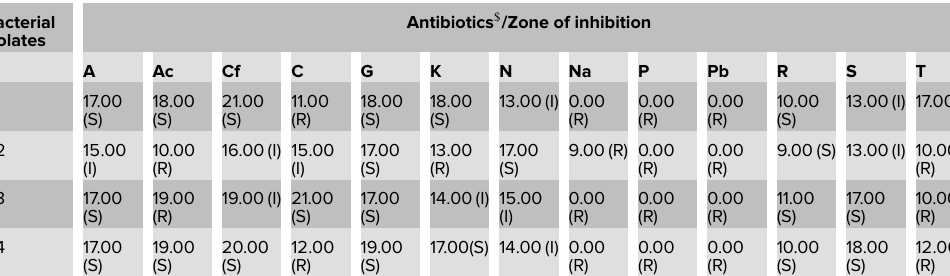
Table 2: Antibiotic susceptibility.